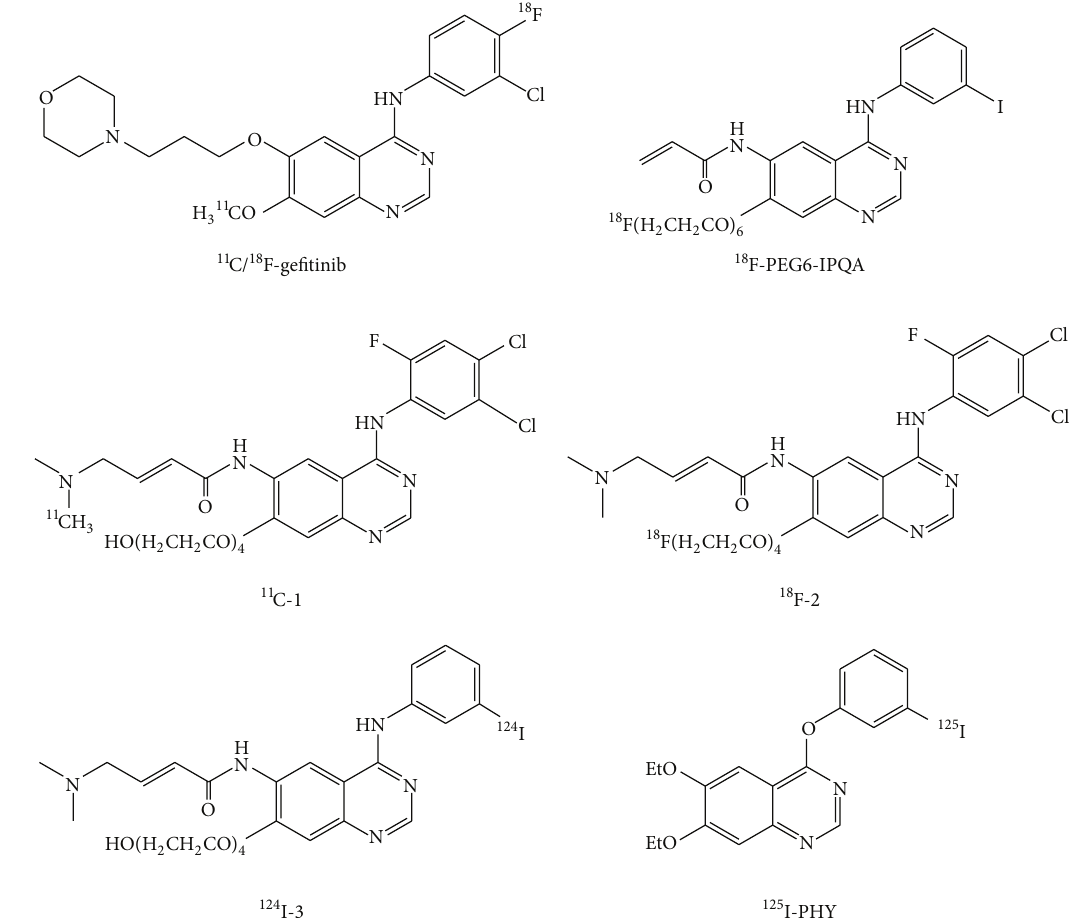
Figure 1: Chemical structures of the EGFR-TK imaging